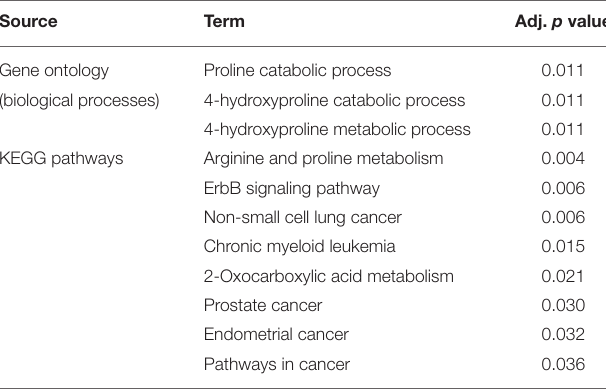
TABLE 3 | Top significantly enriched biological processes and molecular pathways for DEGs ( n = 227) using g:Profiler and DAVID GO.